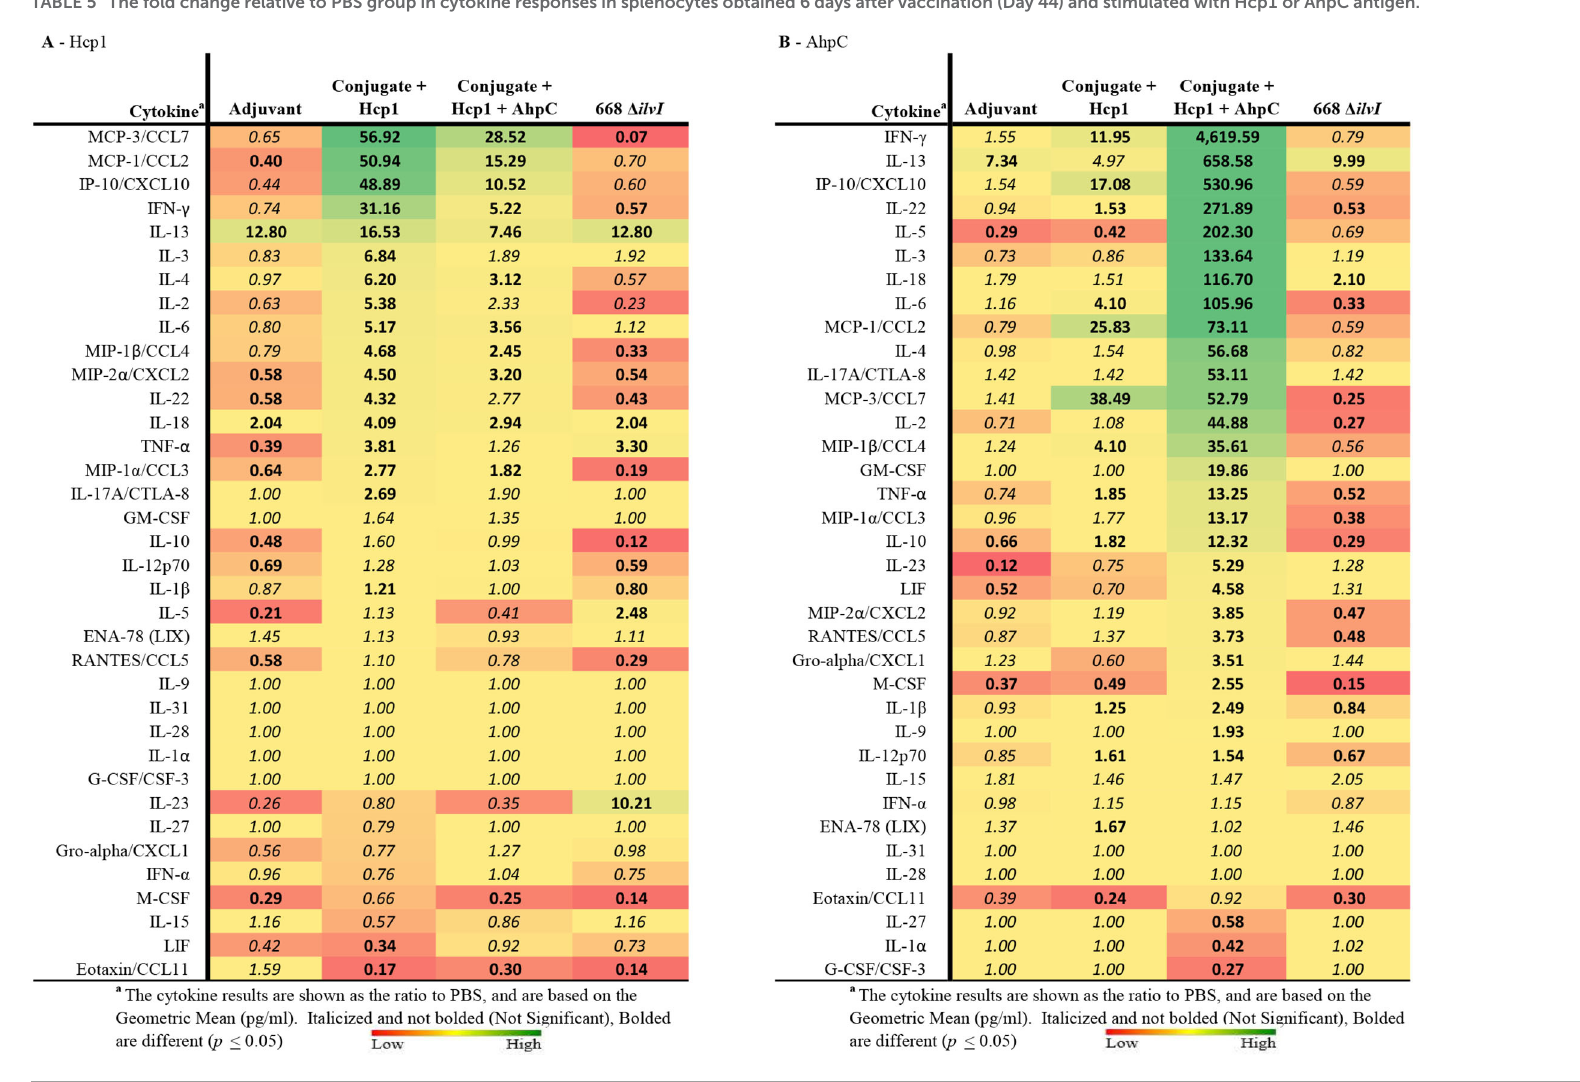
TABLE 5 The fold change relative to PBS group in cytokine responses in splenocytes obtained 6 days after vaccination (Day 44) and stimulated with Hcp1 or AhpC